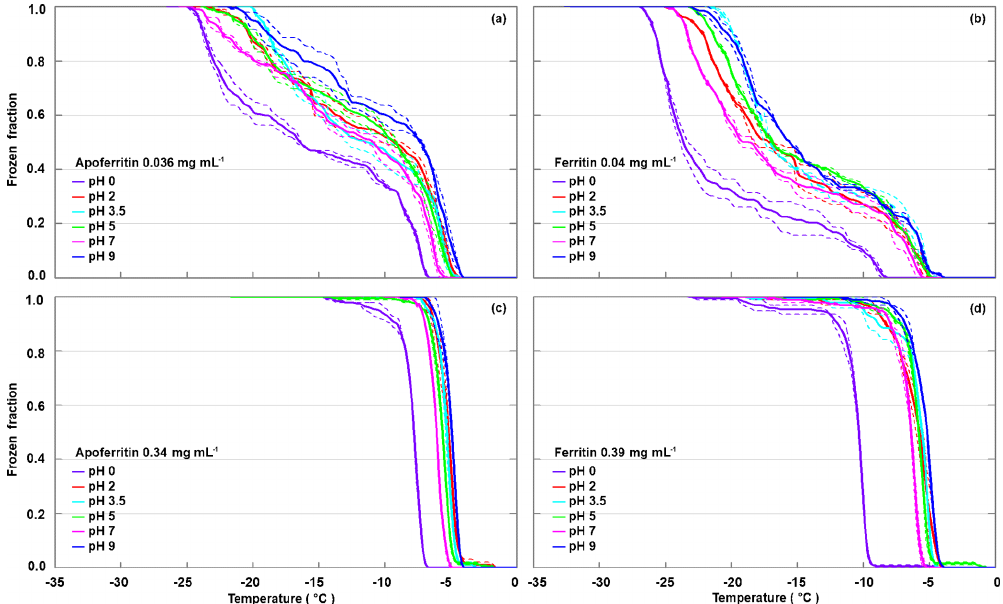
Figure 4. pH dependence of frozen fractions at six different pH values for apoferritin (batch 1, 0.036mgmL − 1 ) (a) , ferritin (batch 1, 0.04mgmL − 1 ) (b) , apoferritin (batch 1, 0.34mgmL − 1 ) (c) , and ferritin (batch 1, 0.39mgmL − 1 ) (d) . Two to three DRINCZ experiments were performed for each concentration (dashed lines) and the means are shown as the thick solid